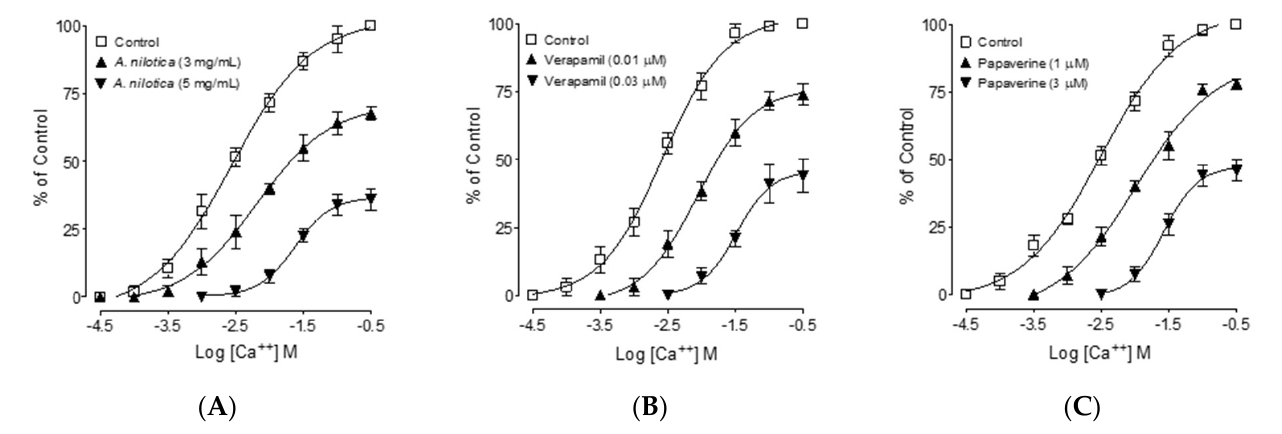
Figure 4. Concentration–response curves of Ca ++ in the absence and presence of the increasing concentrations of the ( A ) methanolic extract of A. nilotica , ( B ) verapamil, and ( C ) papaverine in isolated rat ileum preparations. Values shown are the mean ± SEM, n = 4–5.